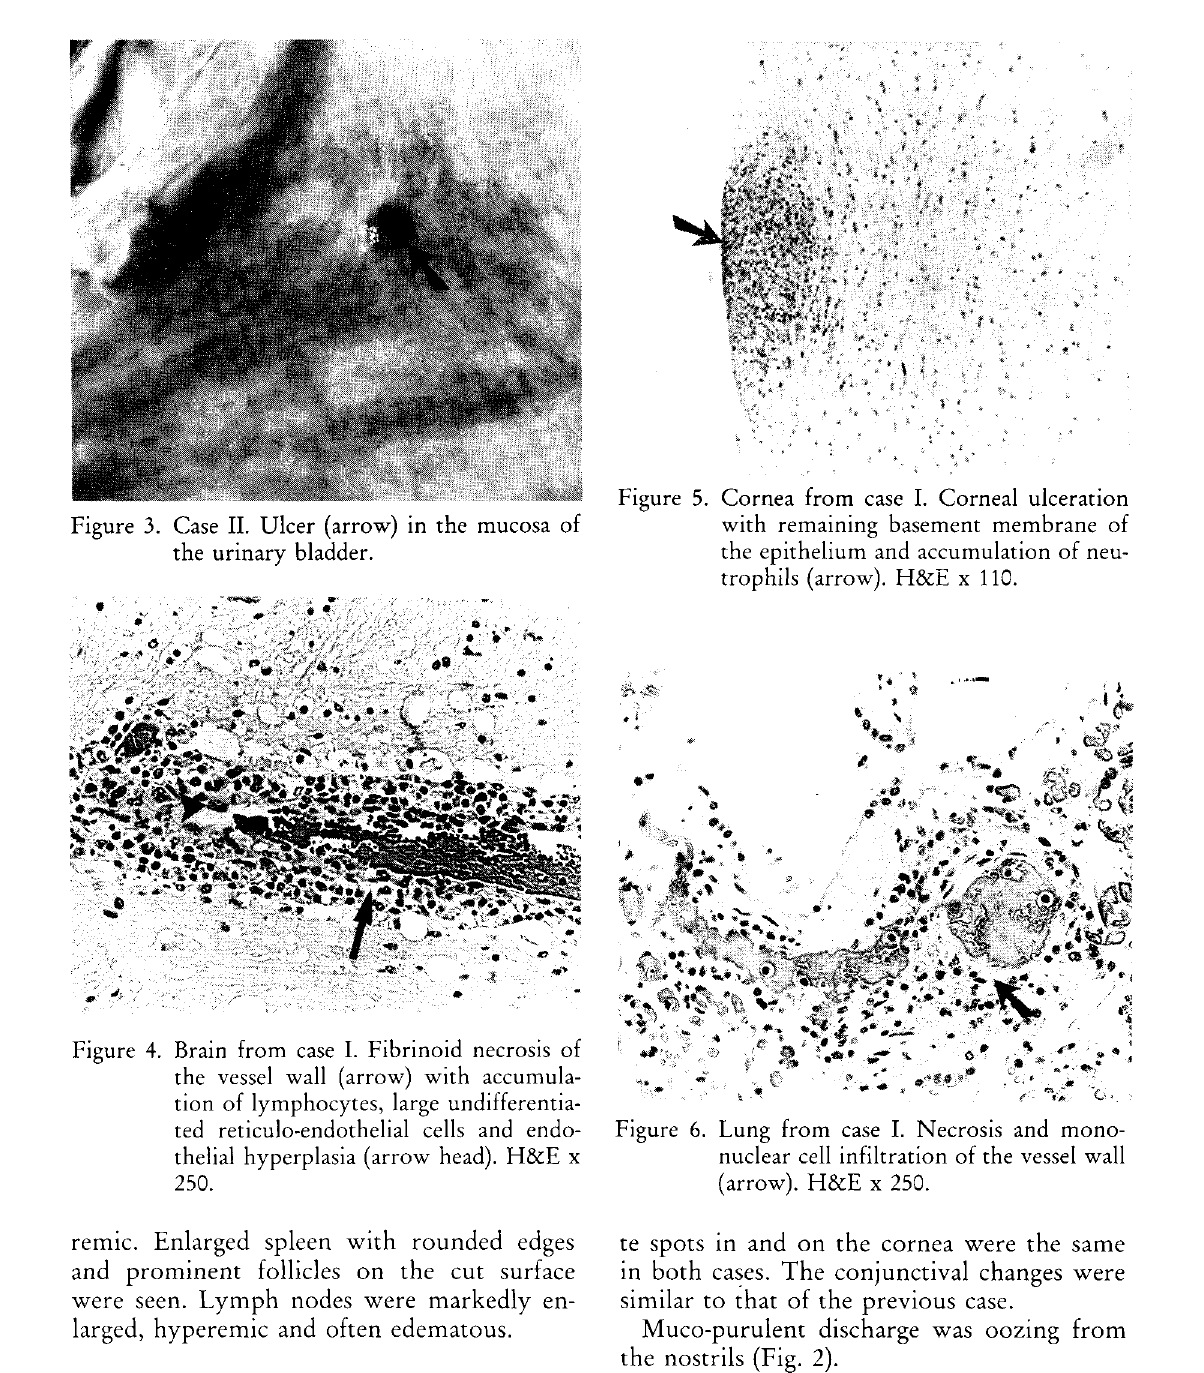
Figure 6. Lung from case I. Necrosis and mono nuclear cell infiltration of the vessel wall (arrow). H&E x